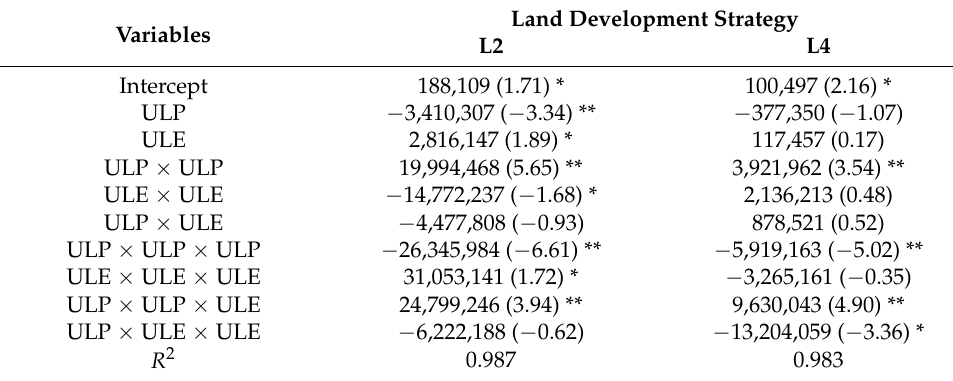
Table 14. Results of 3rd Order Regression of TCOM over ULP and ULE.